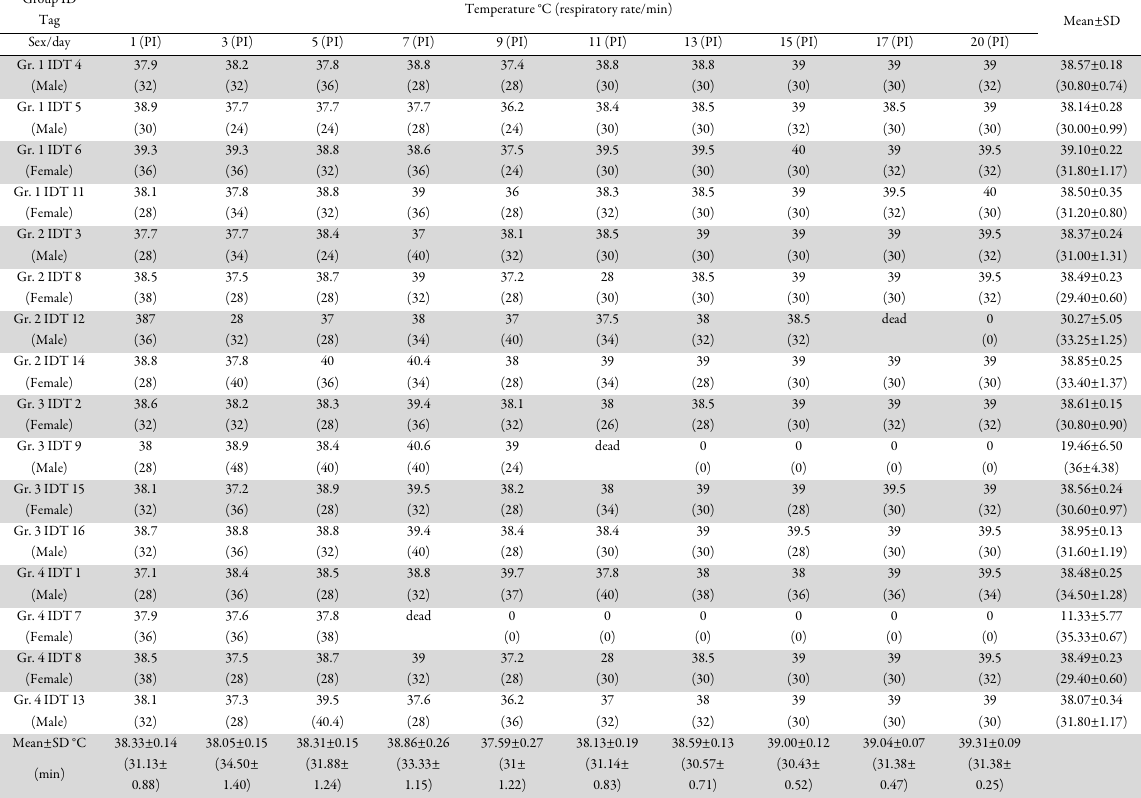
Table 1. Physiological parameters of West African dwarf goats under different treatment combinations Group ID Tag